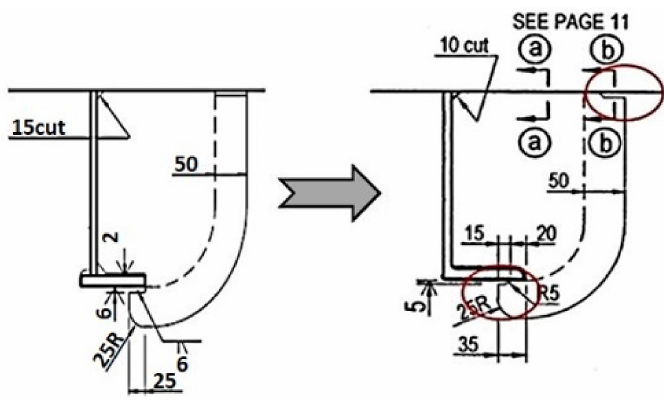
Figure 6. Design drawings for the changed form of filling.